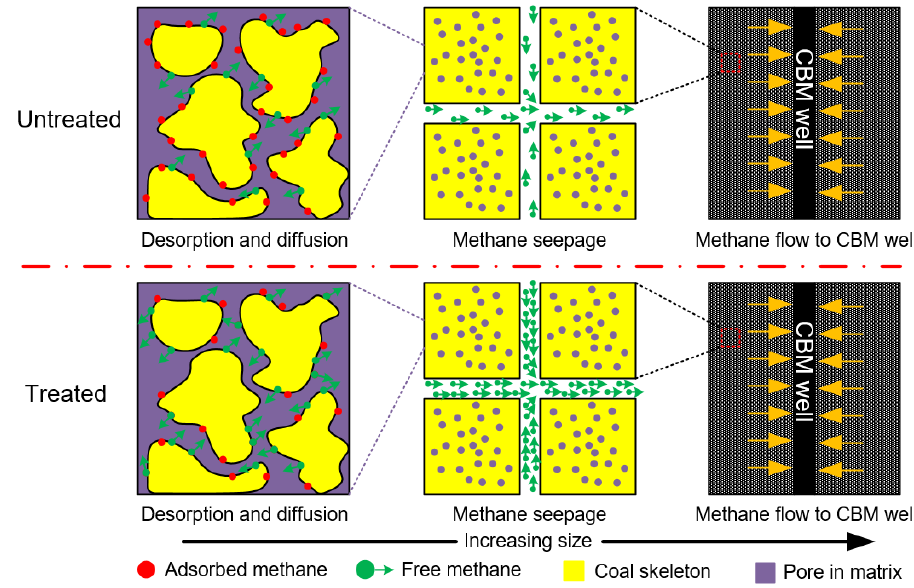
Figure 9. Sketch showing methane migration in untreated and treated coal.